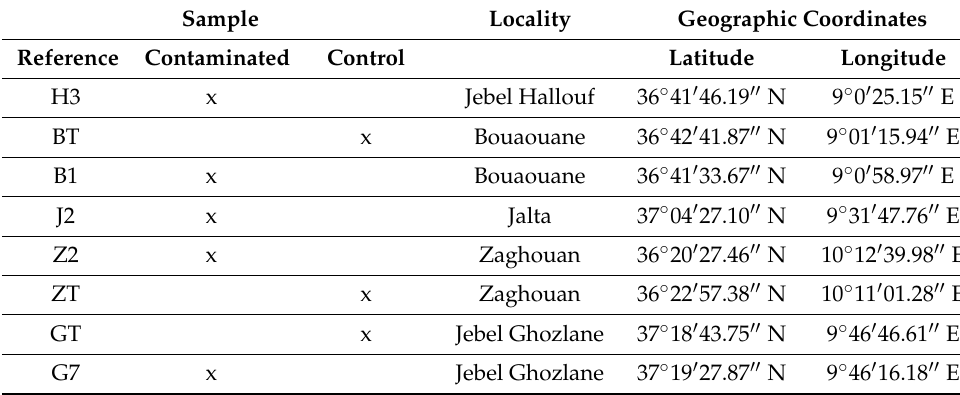
Figure 1. Location map of the study areas. Table 1. Geographic coordinates of the collected samples.